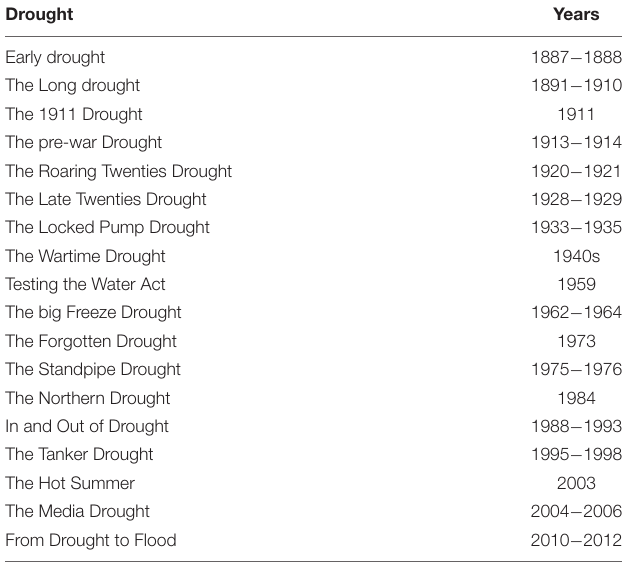
TABLE 1 | List of droughts reported in the Historic Droughts Drought Inventory (https://historicdroughts.ceh.ac.uk/content/drought-inventory), with the additional early drought identified by Jones and Lister